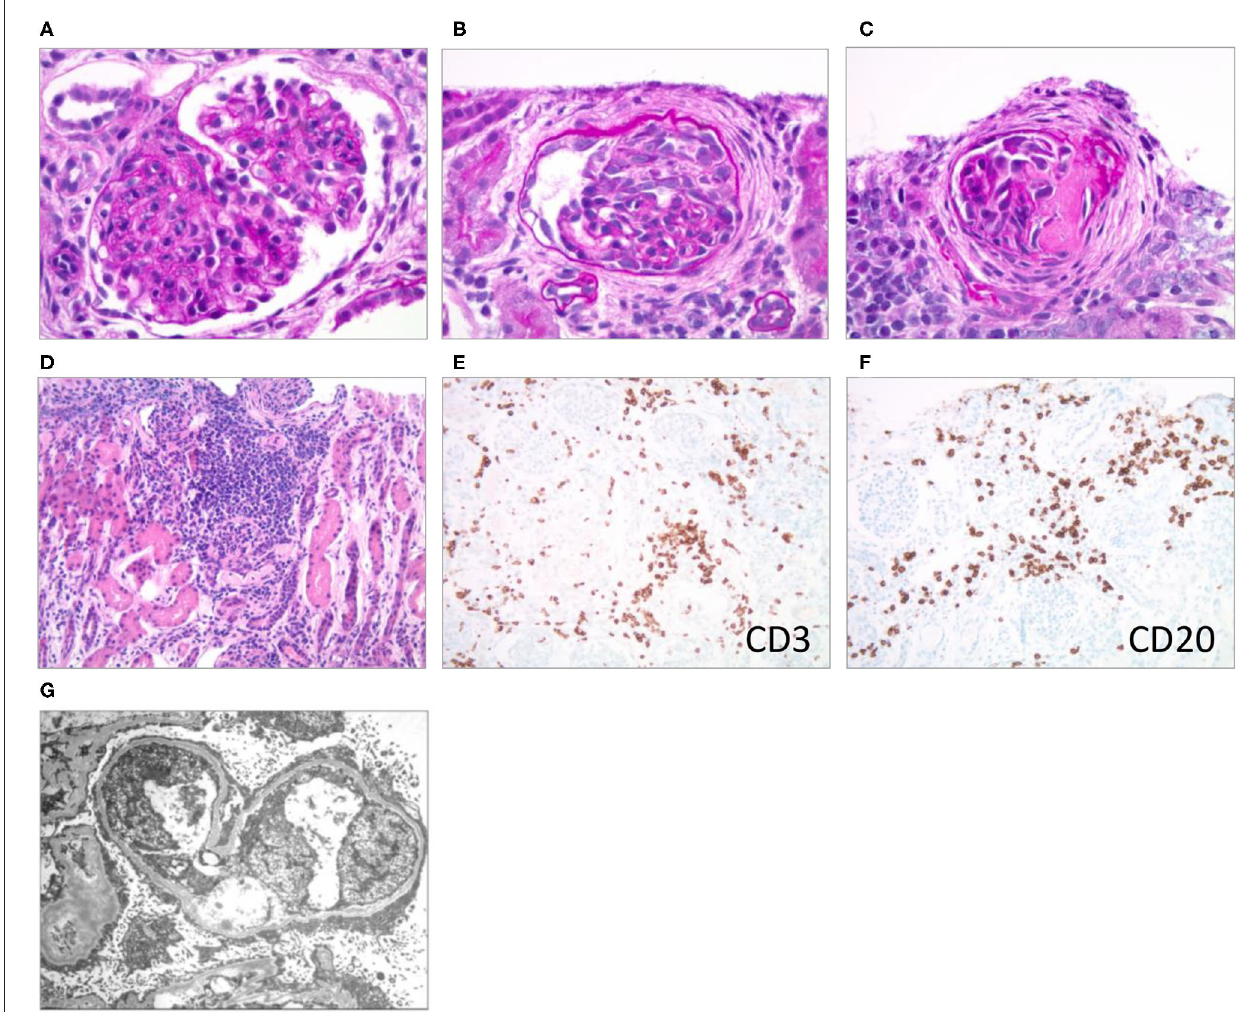
FIGURE 1 | Renal pathological presentation (kidney biopsy of the proband 15 days after admission). (A–C) Brightfield microscopy (PAS stain x600); (D) brightfield (H & E stain x200); (E,F) immunohistochemistry (x200); (G) electron microscopy. (A) Mesangial and endocapillary hypercellularity, (B) cellular crescent, (C) segmental scar/fibrous crescent, (D–F) interstitial infiltrates, (G) diffuse podocyte foot process effacement with prominent microvillous